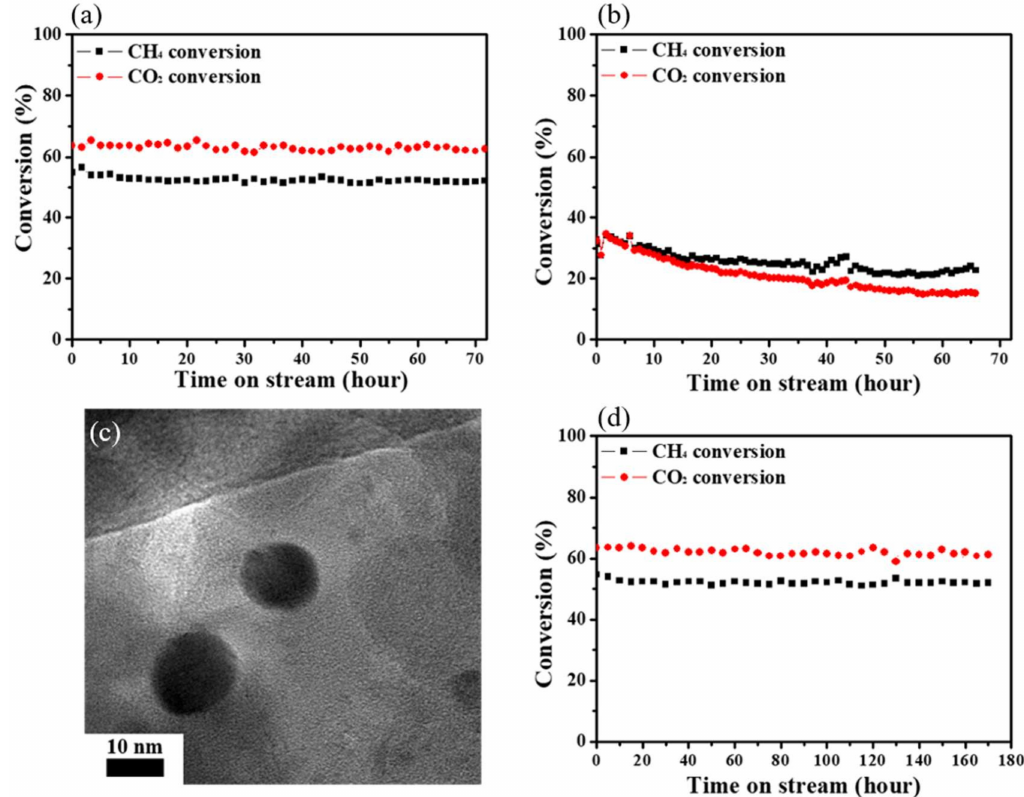
Figure 9. ( a ) CH 4 and CO 2 conversions of Ni/Silica catalyst at 800 ◦ C for 72 h. ( b ) CH 4 and CO 2 conversions of Ni catalyst at 800 ◦ C for 72 h. ( c ) TEM image of Ni/silica obtained after 72 h of the DRM reaction. ( d ) CH 4 and CO 2 conversions of the Ni/silica catalyst at 800 ◦ C for 168 h (7 days). Edited from Reference